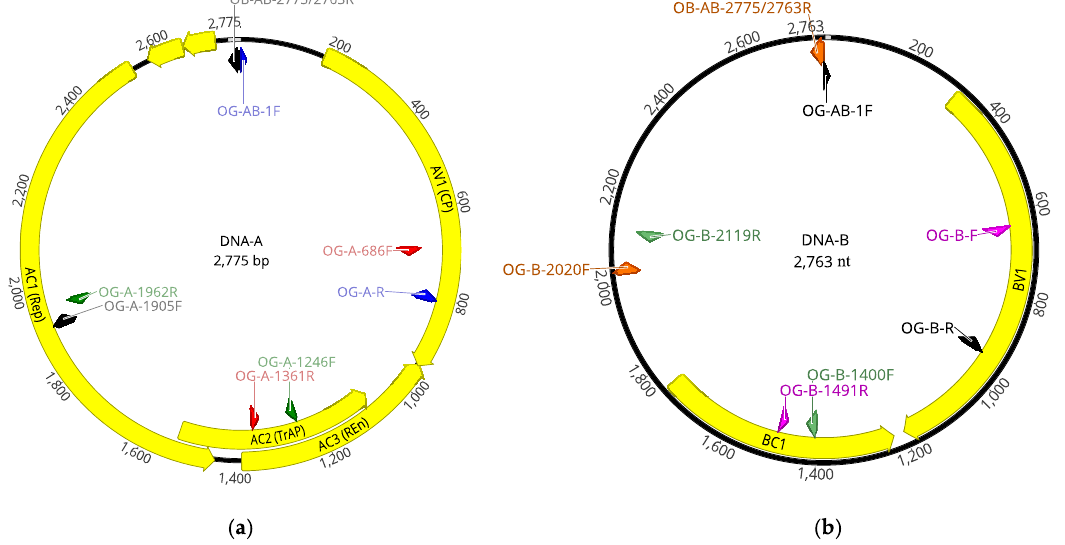
Figure 3. Genomic structure of OEGV isolate V64.2 segments DNA-A ( a ) and DNA-B ( b ). Position of specific primers used to amplify the complete genome is indicated. Each pair of primers used to amplify a specific region of the genome is indicated with the same color. Yellow arrows indicate ORFs.